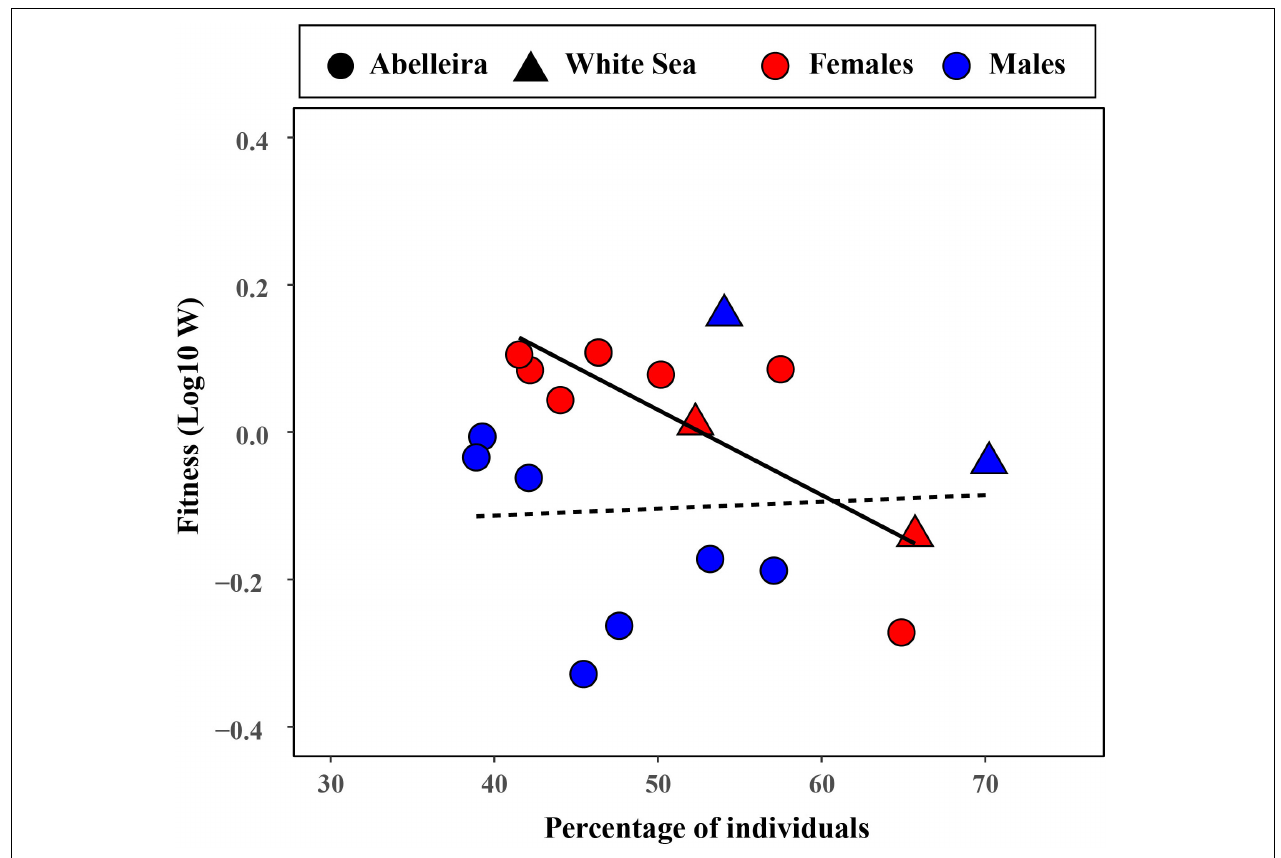
FIGURE 4 | Relationship between fitness (Log10 W) and the percentage of light individuals for each sex of L. fabalis . Each dot represents a year of study in the Abelleira population (2011–2017) while triangles indicate each of the two populations sampled in the White Sea in 2015. Regression lines are shown for females (solid; R 2 = 0.667) and males (dotted; R 2 = 0.004). Notice that, since the W estimator for a given morph is relative to the other morph, using it for one or other morph will yield the same